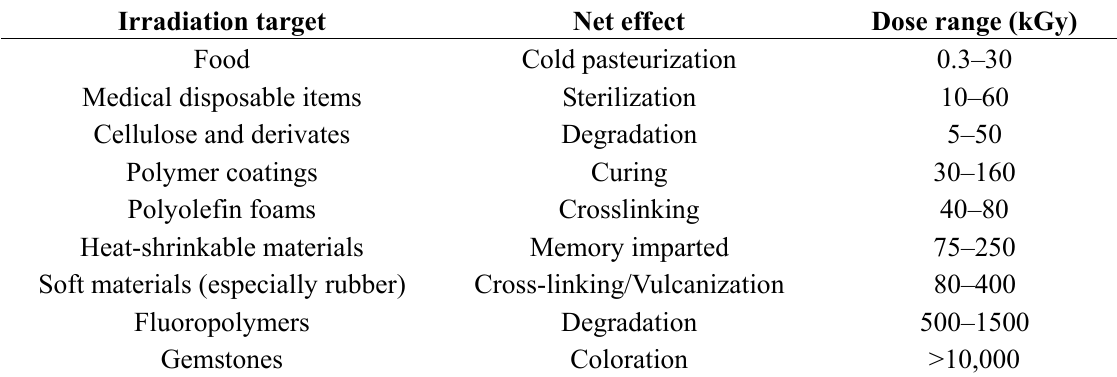
Table 1. Selected industrial applications of irradiation processing